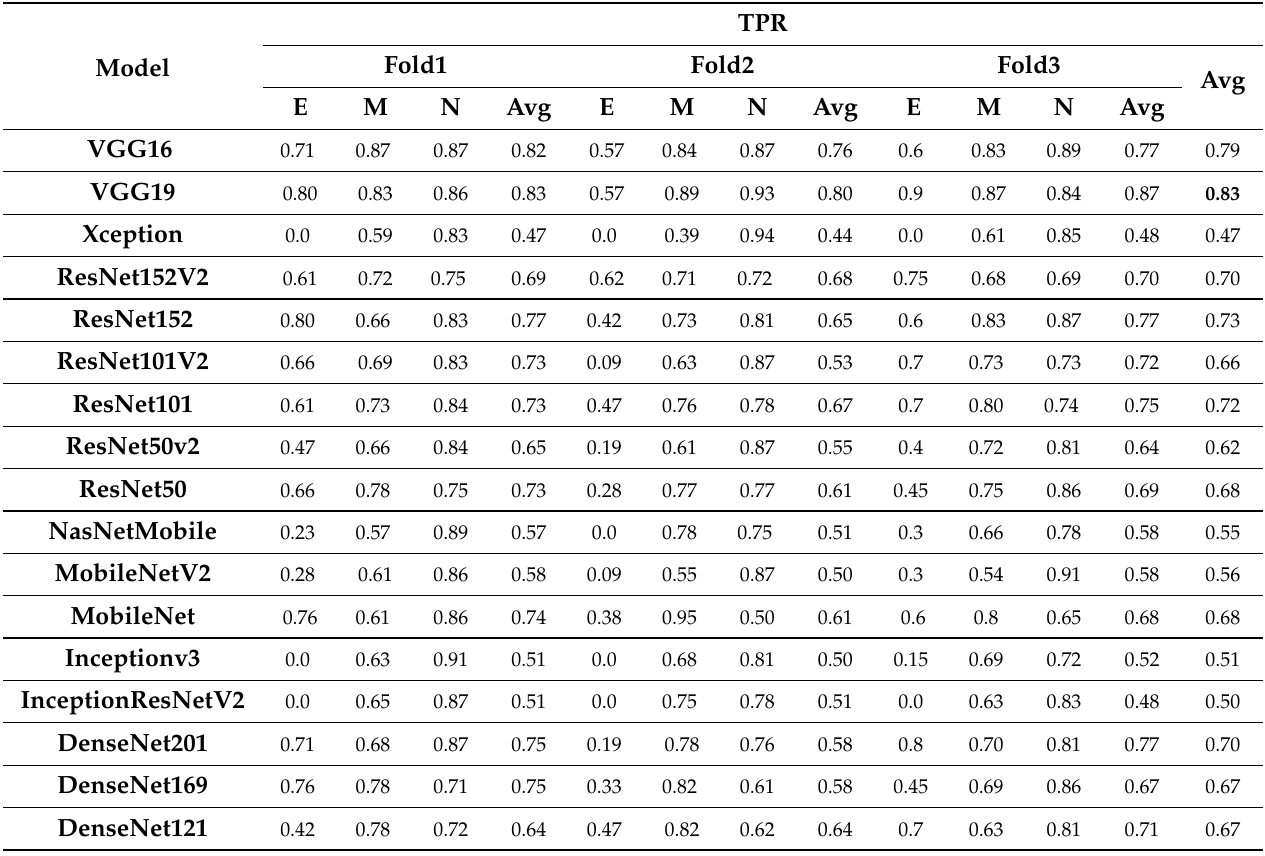
Figure 11. Overview of CNN models average training time VS average validation accuracy with selection process. Table 7. Validation TPR of CNN models using 3 class (E: Extrasystole; M: Murmur; N: Normal) 3 folds with selection